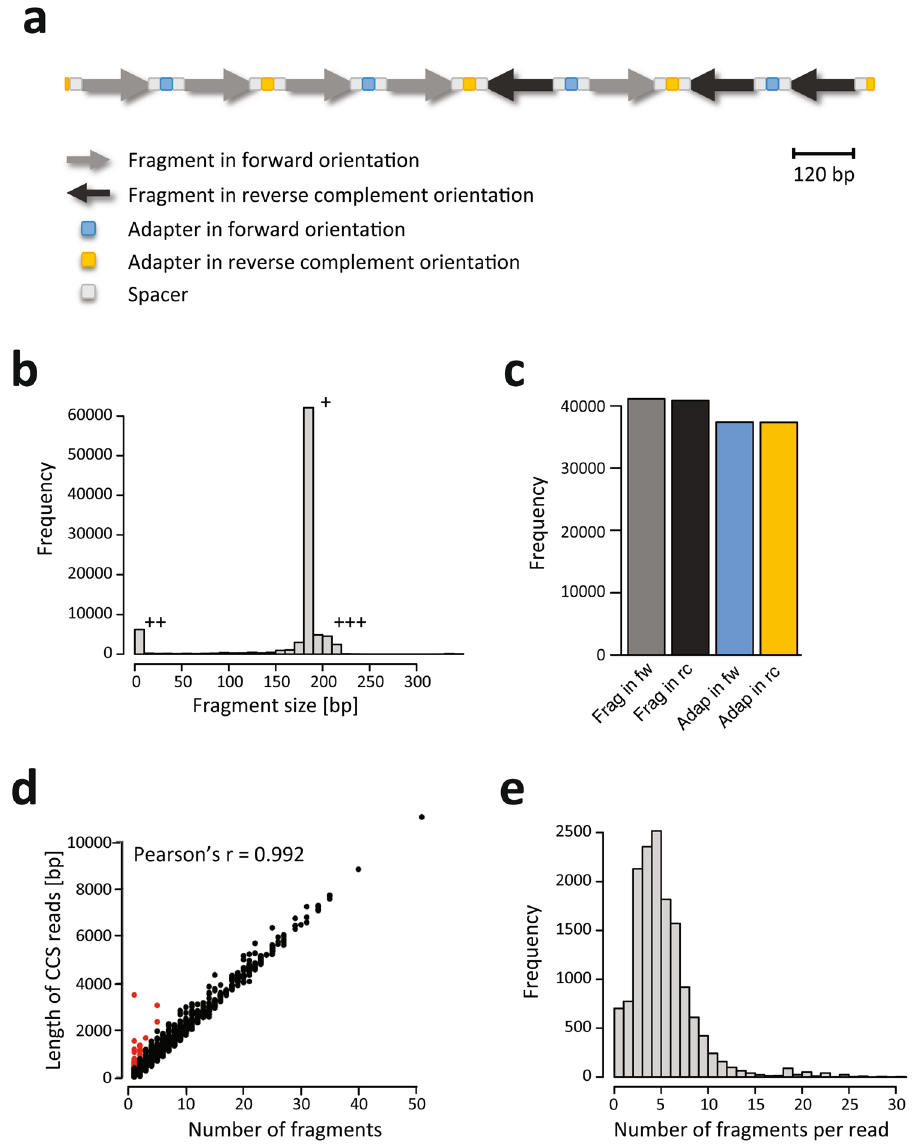
Figure 2. ConcatSeq can increase sequencing throughput by more than five-fold. ( a ) Schematic of the architecture of one example read (read number 5 in SRR5168830), depicting types and orientation of different sequence features identified: fragments and adapters in forward and reverse complement orientation, and spacers. ( b ) Histogram depicting the frequency of fragments in each size bin (10 bp interval) after deconcatenation of sequencing reads using the adapter scanning approach. + : fragments with exactly (187 bp) or very close to the expected size (180–190 bp); ++ : fragments that are shorter than 10 bp; +++ : fragments that are slightly larger than the expected size ( > 190 bp). ( c ) Barplot depicting the number of fragments [Frag] that aligned to the reference and adapters [Adap] that were identified by the adapter scanning approach in forward [fw] and reverse complement [rc] orientation in all reads. ( d ) Scatterplot depicting the relationship between read length and number of fragments identified in that read. Red dots indicate the cases in which the read was significantly longer than the length expected by the number of fragments identified in that read. ( e ) Histogram depicting the frequency of number of fragments identified per read across all reads. For clarity, the histogram was truncated at 30 fragments per